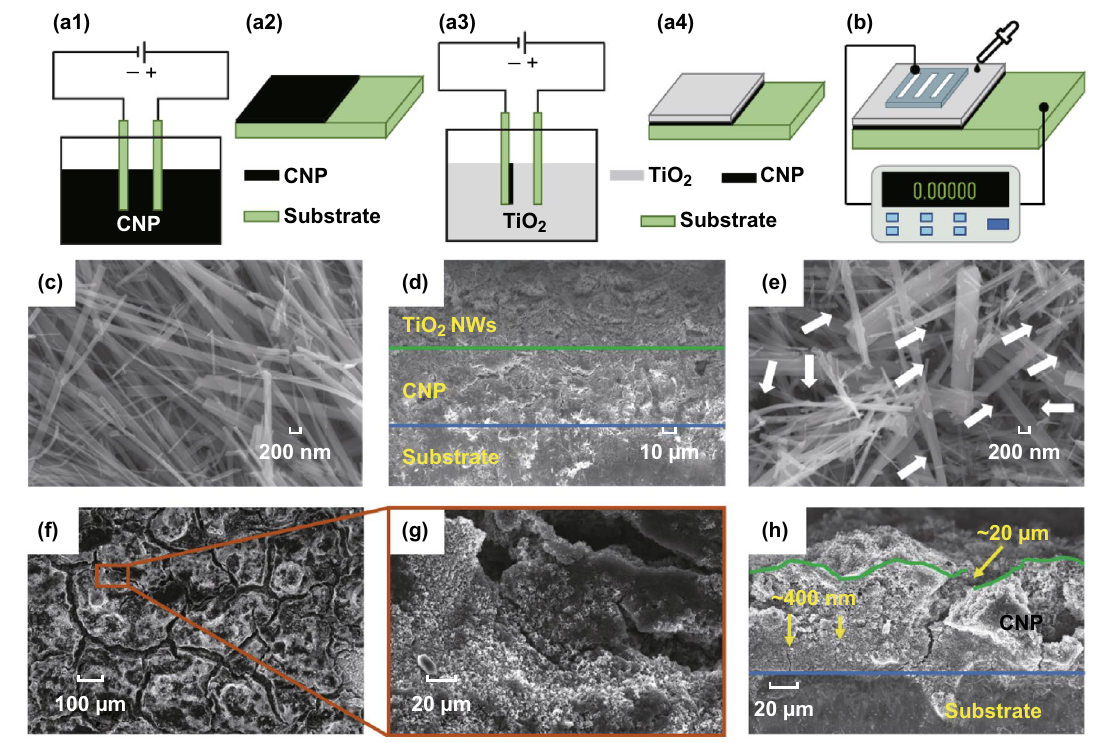
Fig. 1 a Schematic showing the relevant steps in the sequential deposition of the CNP films and the TiO 2 NWs onto a Ti electrode. b Measure- ment of open-circuit voltage and short-circuit current. c SEM image of as-synthesized TiO 2 NWs. d A cross-sectional view of the films depos- ited on the Ti electrode. The Ti-CNP boundary is indicated with the blue line, while the CNP-TiO 2 NWs boundary is shown as the green line. e Morphology of the top surface of the TiO 2 NWs film in the C-T generator. f The top surface of a CNP film after a 4-min deposition. g Magnified image of the selected area in f . h A cross-sectional view of the CNP films. (Color figure